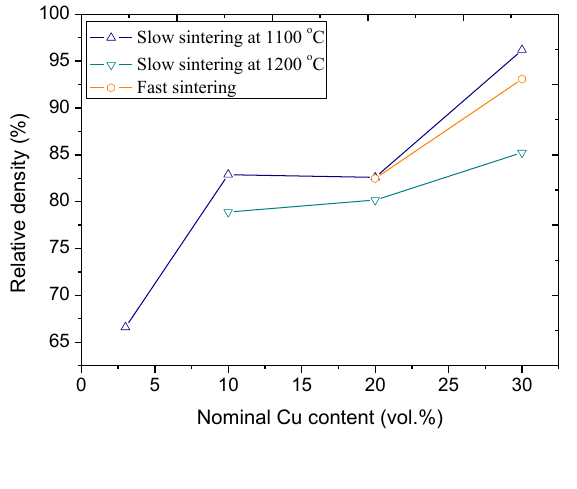
Figure 8. Relative density of TiB 2 -Cu cermets calculated based on experimentally determined volume fraction of Cu using Rietveld